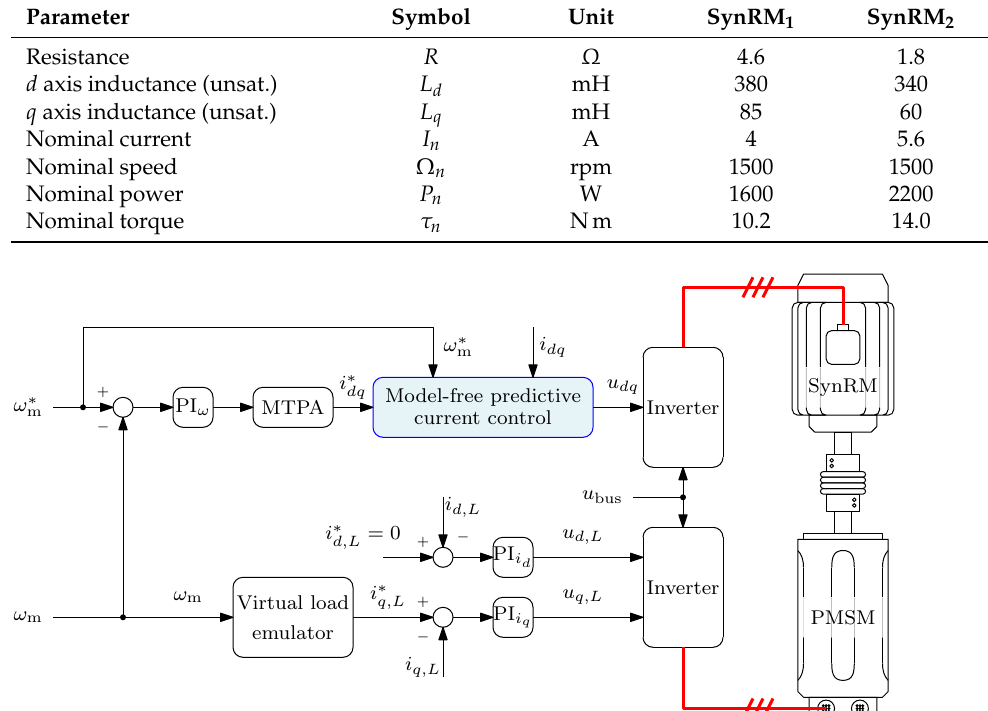
Figure 4. Scheme of the proposed control drive and test rig